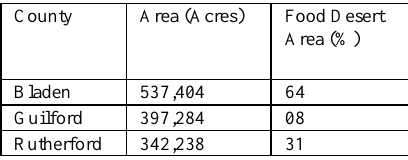
Table 1: Summary